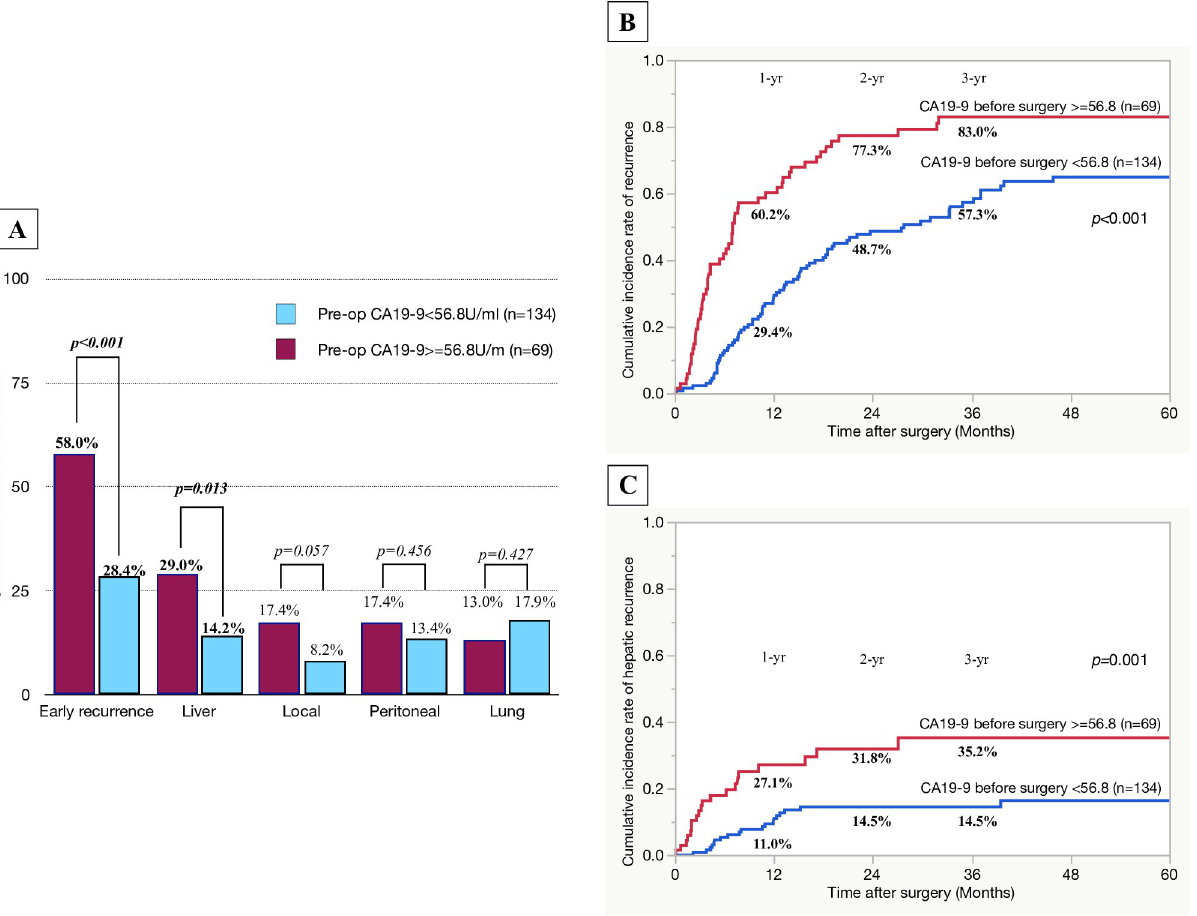
Fig 3. Comparison of overall and cumulative incidence rate of recurrence after surgery based on the serum level of CA19-9 level before surgery (= > 56.8/ < 56.8 U/ml). A: overall incidence rate of early recurrence and site of recurrence after surgery; B: cumulative incidence rate of recurrence after surgery; C: cumulative incidence rate of hepatic recurrence after